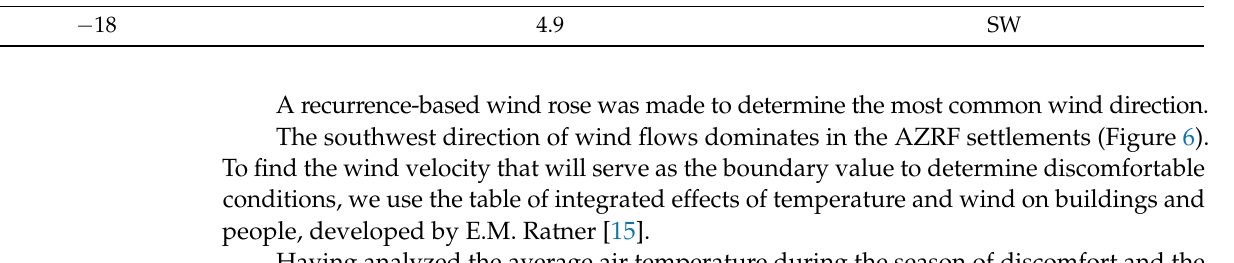
Table 1. Average statistical aeration parameters of AZRF settlements in the winter period. Average Air Temperature in the Average Wind Speed, M/S, in the Period Season of Discomfort